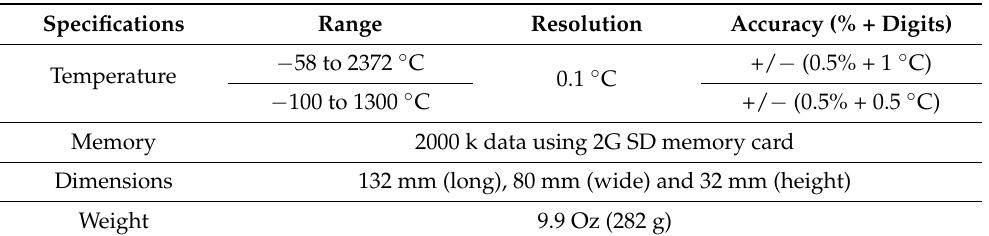
Table 5. Technical specifications of the EXTECH SD200 3-Channel Temperature Datalogger (taken from its datasheet) [17].